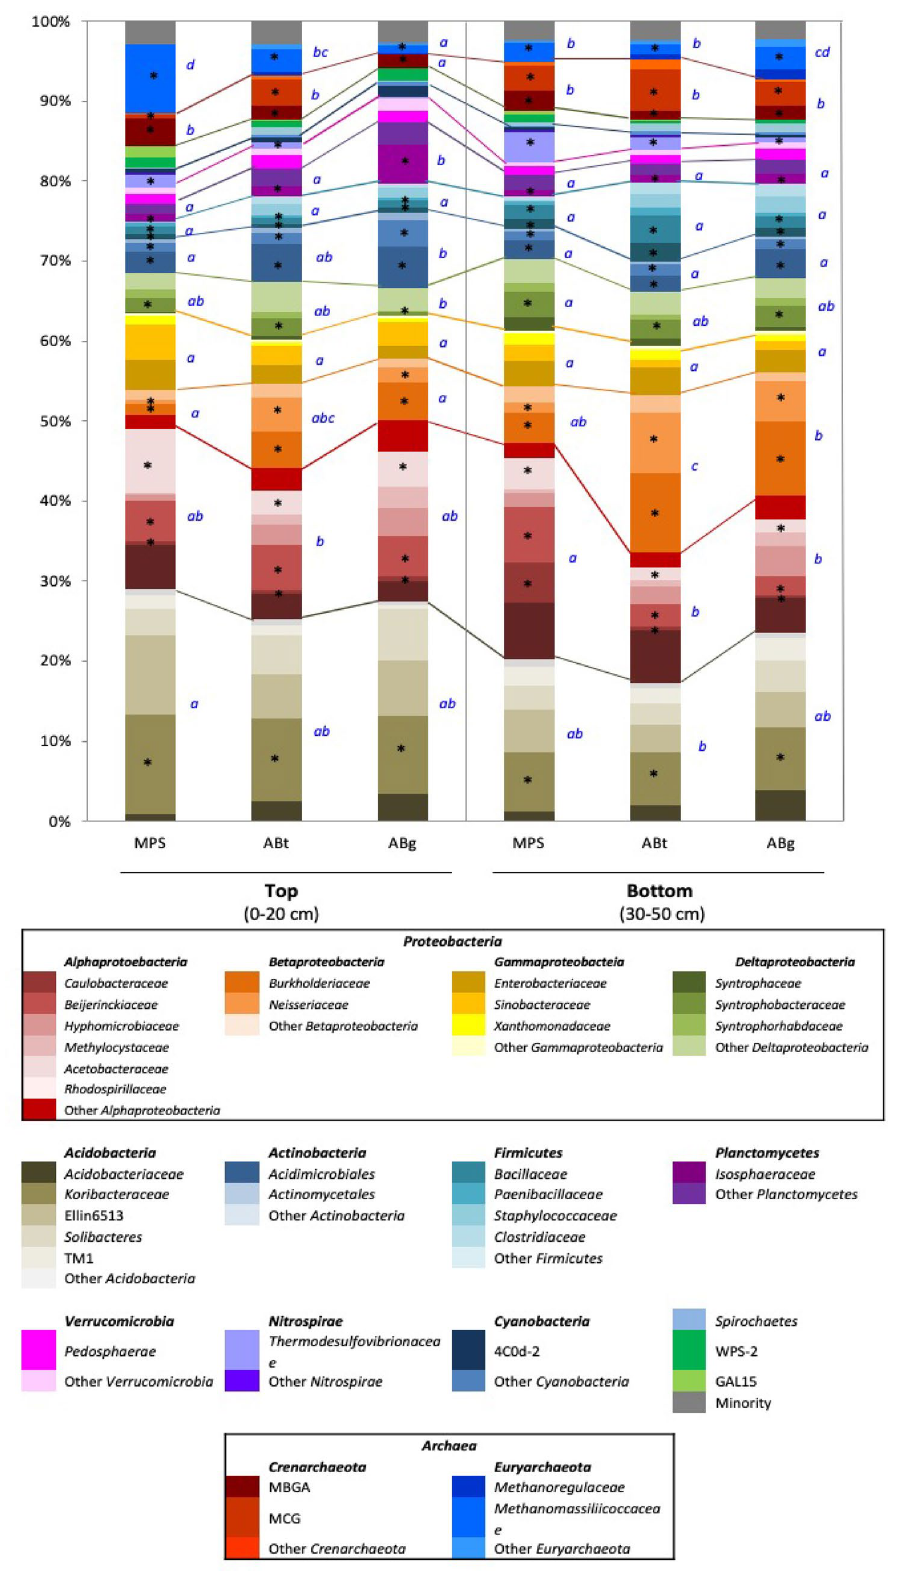
Figure 2. Comparison of prokaryotic microbiota composition in MPS, ABt, and ABg forest at two depths, 0–20 cm (T) and 30–50 cm (B) below the soil surface. Only those taxa with relative abundance higher than 1% were shown and each colour represents a particular taxon of prokaryotic groups. MBGA represents Marine Benthic Group A and MCG represents Miscellaneous Crenarchaeotic